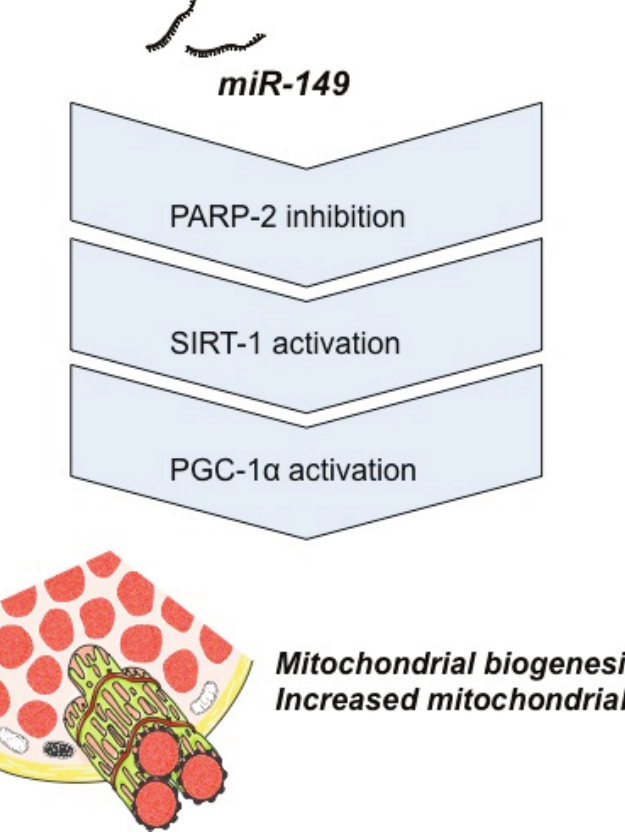
Figure 1. Schematic representation of the action of miR-149 in skeletal muscle mitochondrial biogenesis, via sirtuin-1 (SIRT-1)/peroxisome proliferator–activated receptor (cid:5) coactivator-1a (PGC-1(cid:6)) axis. In obese mice, miR-149 is downregulated and mitochondrial function is reduced in the